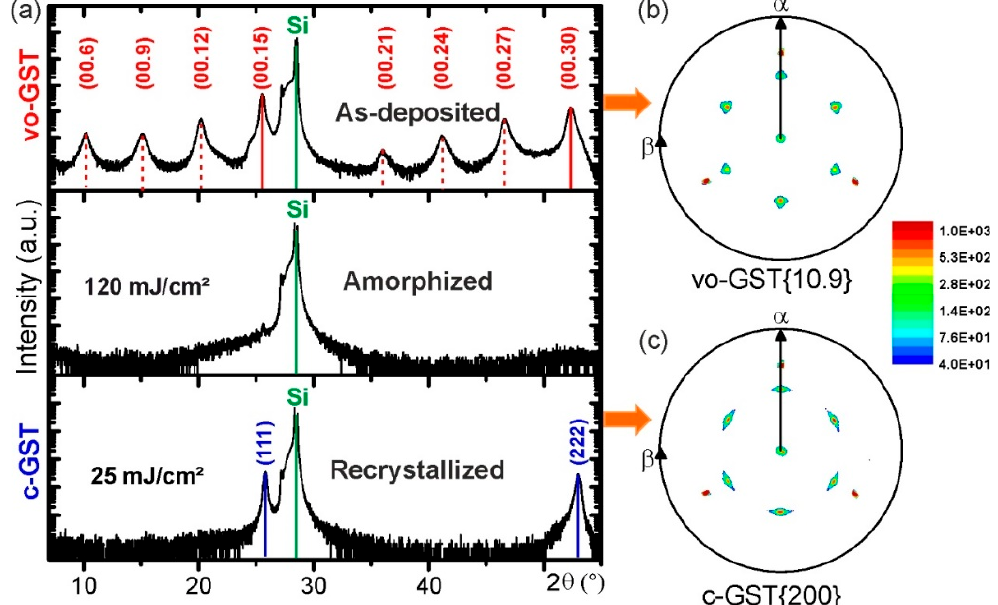
Figure 1. ( a ) XRD patterns of reversible crystalline-to-amorphous phase transitions in an epitaxial GST thin film induced by ns-laser irradiation. The upper XRD pattern originates from the as-deposited vo-GST thin film. The middle pattern corresponds to the thin film after applying a single ns-laser pulse with a fluence of 120 mJ / cm 2 leading to amorphization. The bottom pattern is related to the thin film after recrystallization by applying a single ns-laser pulse with a fluence of 25 mJ / cm 2 . The di ff ractogram of as-deposited vo-GST thin film shows superstructure reflections (vacancy layer peaks) marked by red dashed lines beside the main reflections marked by red continuous lines. The continuous blue and green lines mark (111) lattice planes in the c-GST and Si substrate, respectively. ( b ) and ( c ) XRD pole figure measurements of as-deposited and recrystallized GST thin film.